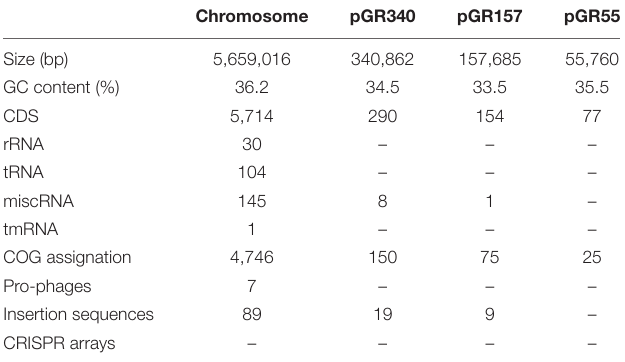
TABLE 2 | Features of the genome of Bacillus thuringiensis GR007 strain. TABLE 3 | Genes coding for virulence factors in Bacillus thuringiensis GR007